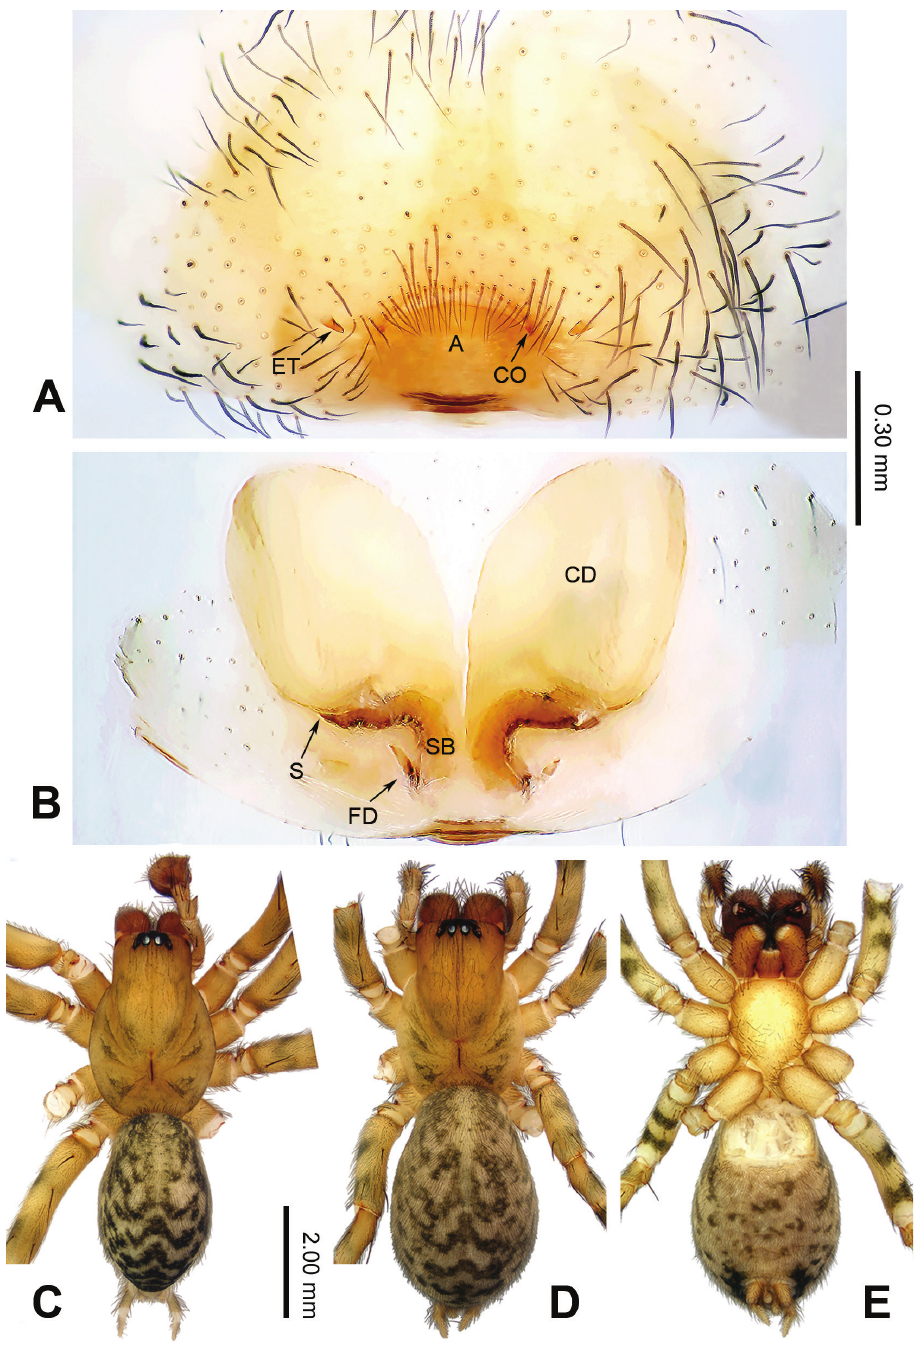
Figure 6. Epigyne and habitus of Guilotes xingpingensis sp. n. A Epigyne, ventral B Vulva, dorsal C Male habitus, dorsal D Female habitus, dorsal E Female habitus, ventral. Scale bars equal for C–E